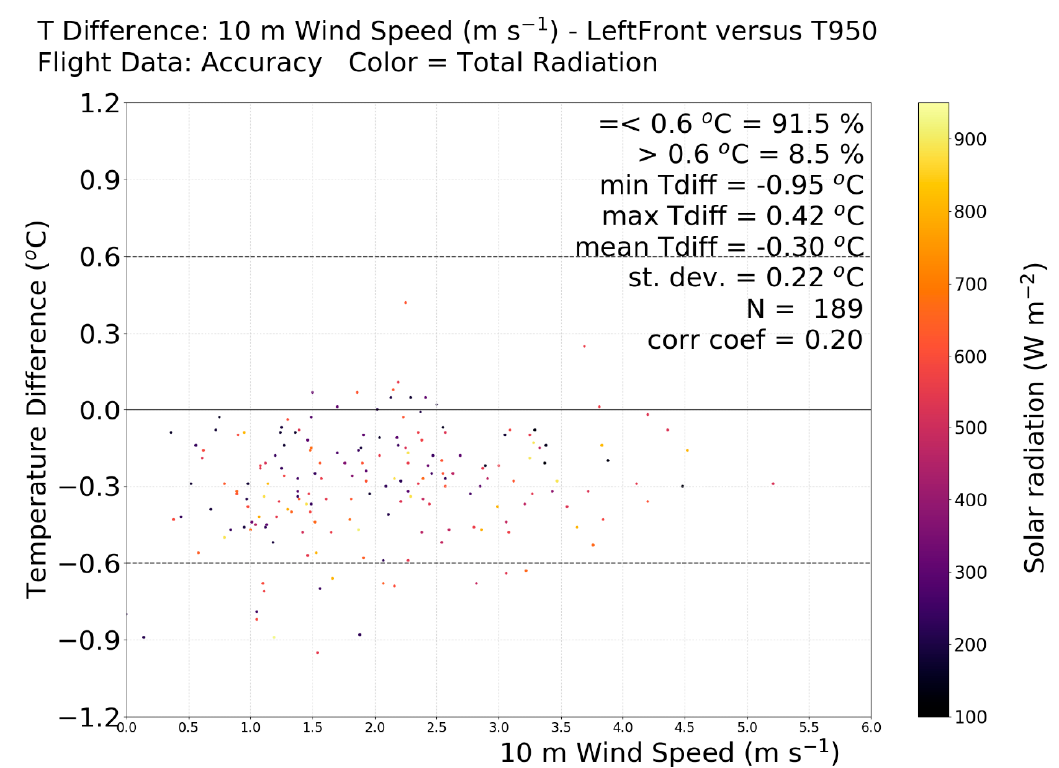
Figure 10. Temperature differences (°C) for the iMET-XQ location “LeftFront” as a function of 10 m wind speed (x axis, m s − 1 ) and solar radiation (color, W m − 2 ).